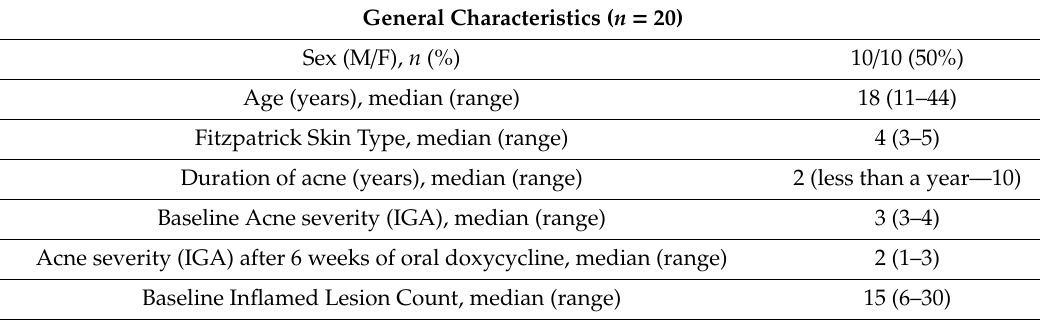
Table 1. Demographic and clinical characteristics of the study participants.